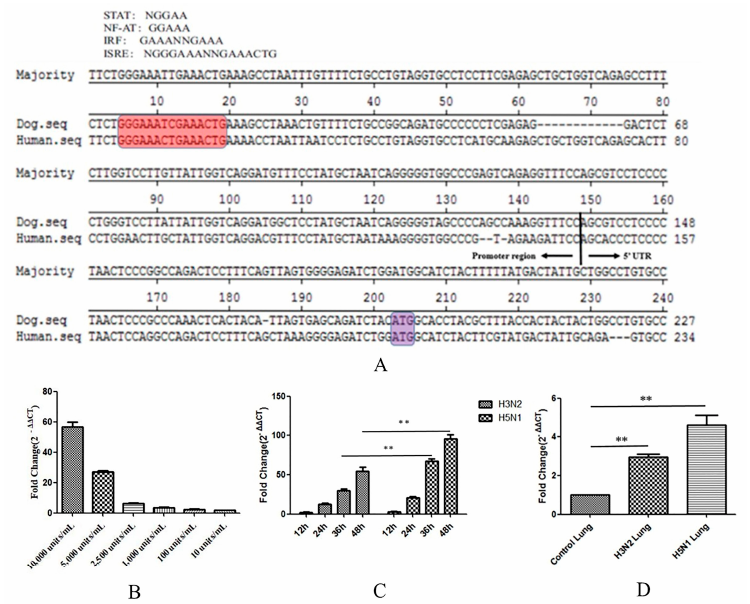
Figure 6. The expression of canine tetherin is inducible by IFN- α . ( A ) Nucleotide sequence alignment of the 5 ′ flanking regions of canine tetherin and human tetherin. The sequence from 5 ′ RACE of the canine tetherin gene and the putative promoter region were compared with those of the human tetherin gene. Putative regulatory elements conserved across different species are shaded in red. The translational start codons are shaded in purple; ( B ) induction of tetherin expression by IFN- α at different dilution ratios; ( C ) the level of canine tetherin expression in infected MDCK cells; ( D ) the level of canine tetherin expression in infected canine lungs. Nine uninfected beagles were randomly divided into the following groups: H3N2, H5N1 and control (mock-infected dogs). In the H3N2 and H5N1 groups, dogs were inoculated intranasally with 10 6.0 -times the 50% tissue culture infective dose (TCID 50 ) of the virus. Control dogs received 1 mL of phosphate-buffered saline (PBS). The dogs were euthanized at 3 days post-infection (dpi) in each group based on previous studies. Samples were analysed in triplicate and GAPDH was used as an endogenous control for normalization. Fold changes were calculated using the 2 −ΔΔ C T method. Each experiment was conducted three times independently and the data analysis was conducted in SPSS (Statistical Program for Social Sciences) with independent t -tests; a p value less than 0.05 was considered statistically significant (** p < 0.01). The error bars represent the standard deviation.